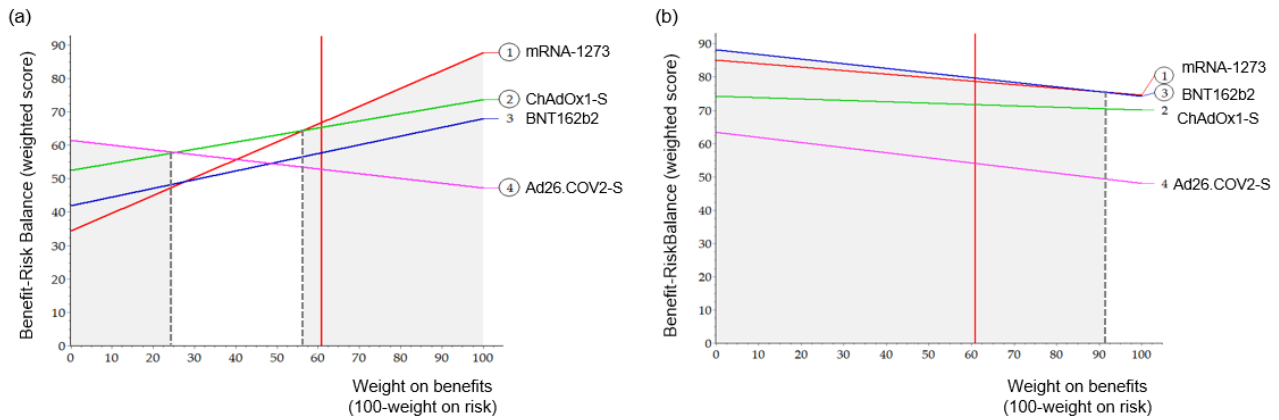
Figure 5. Sensitivity analysis for weight. A vertical black dashed line indicated the point of the pre- ferred vaccine change. ( a ) Pre-authorization, ( b ) Post-authorization preferred vaccine change. ( a ) Pre-authorization, ( b )